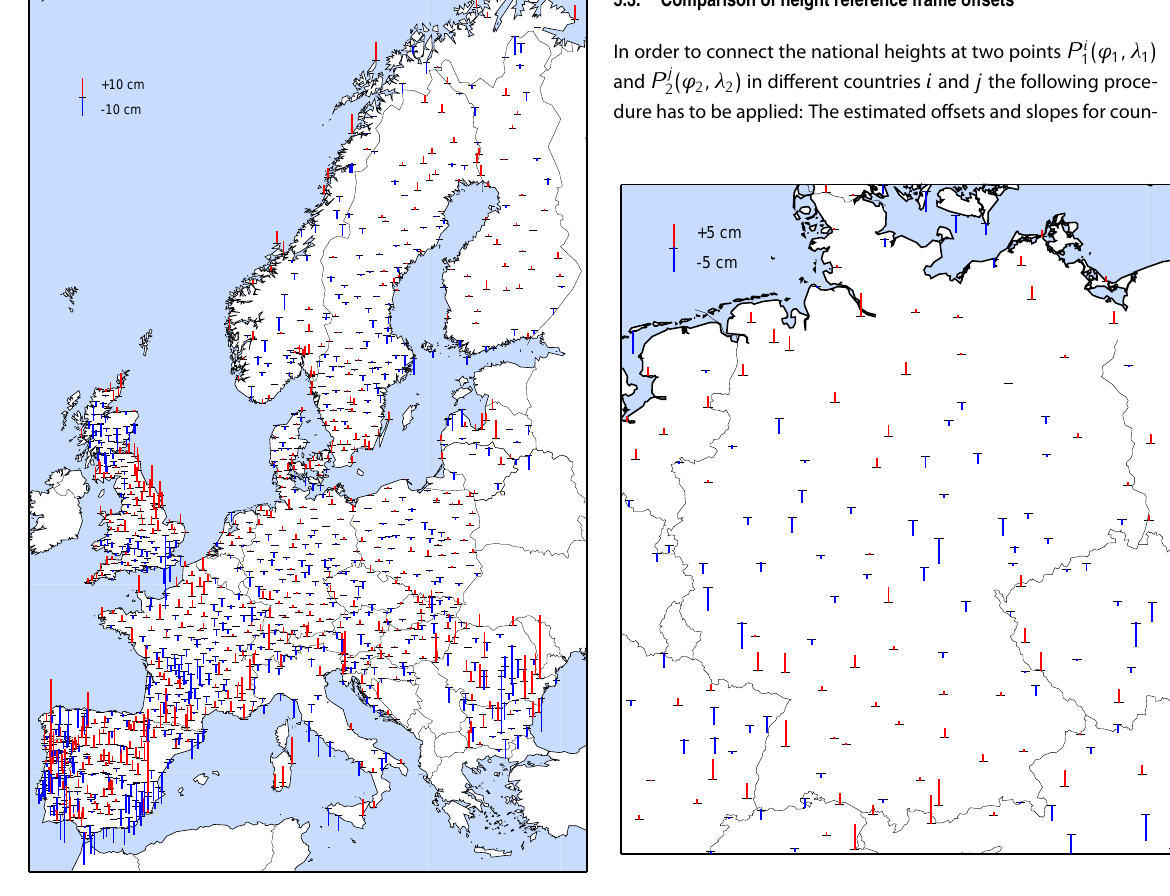
Figure 6. Residuals of observed height anomalies at European GNSS/leveling points vs. plane model computed with the GF approach in Germany. The filter-combined GOCO03S+EGG2008 model has been used as the gravity field